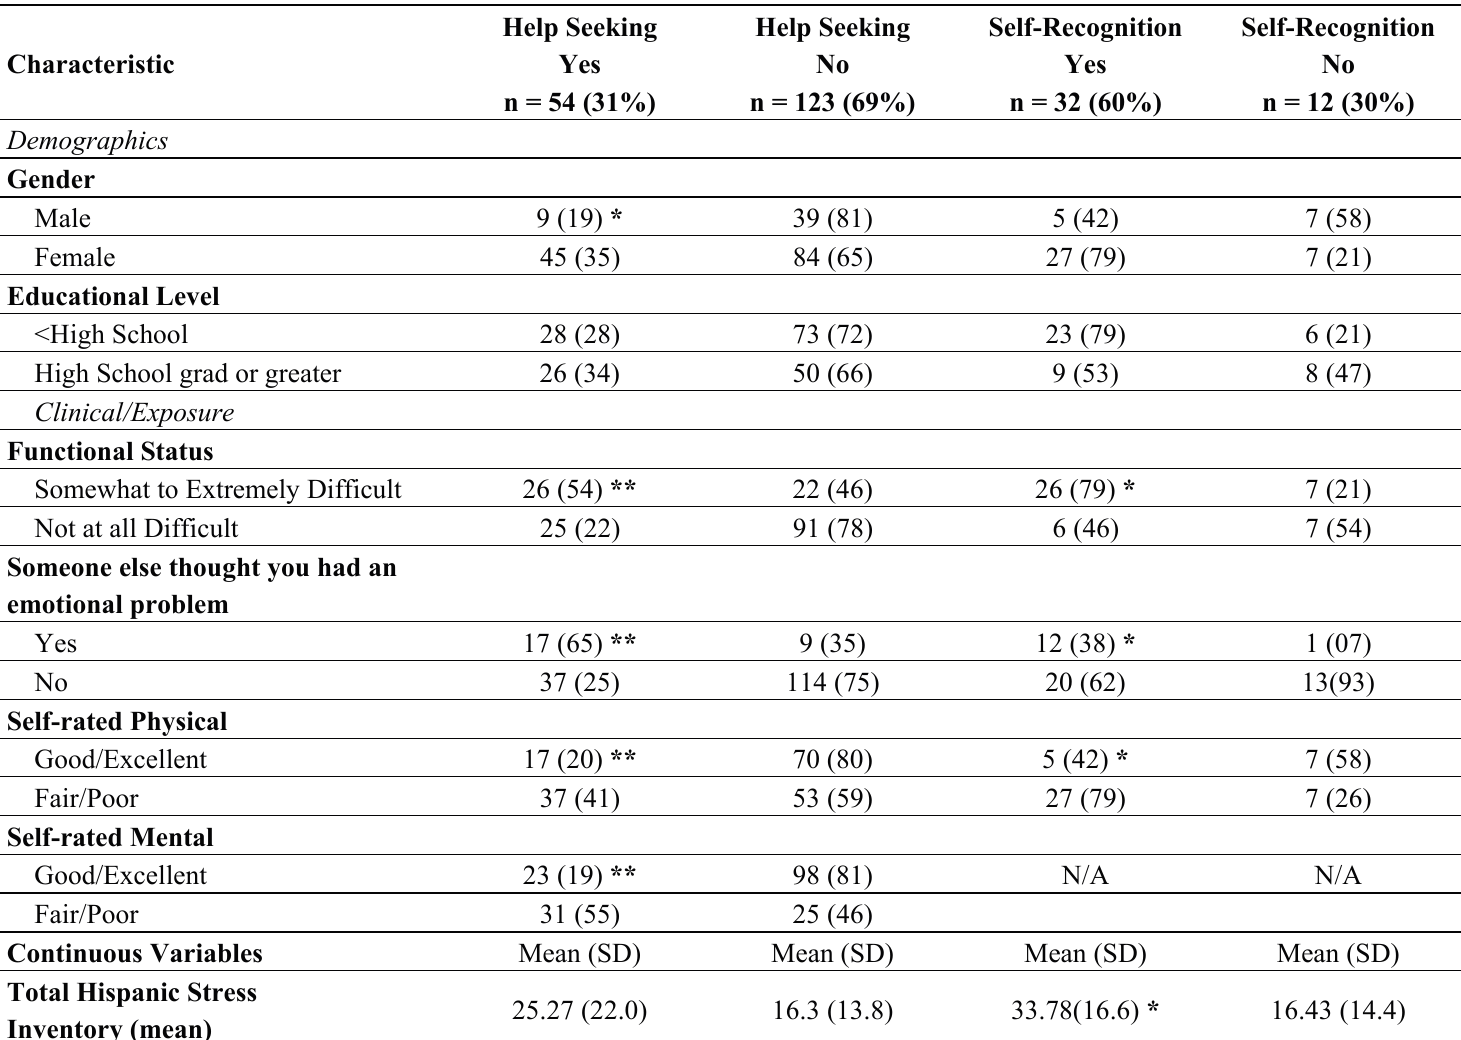
Table 3. Bivariate associations with help seeking and